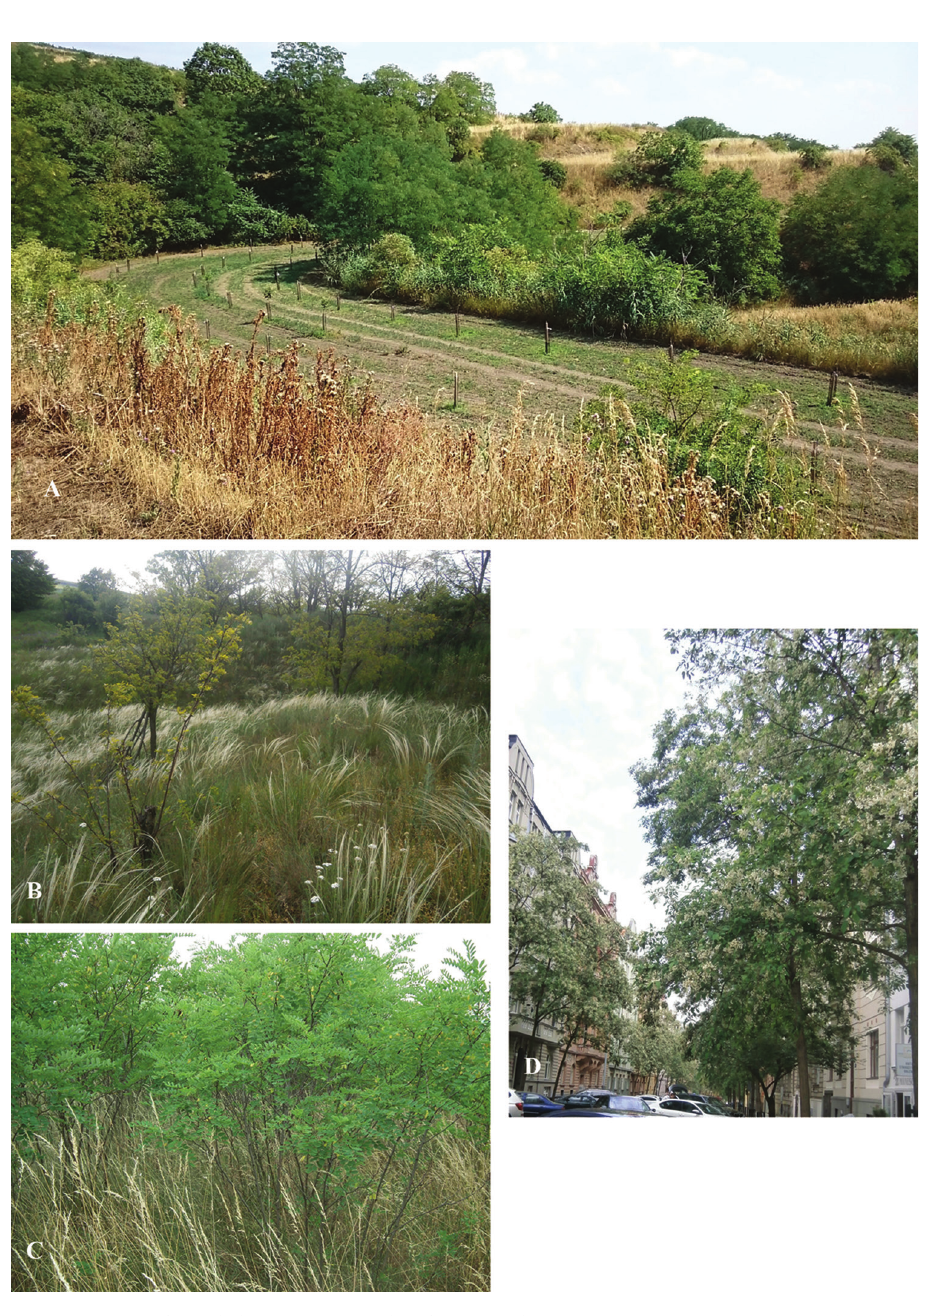
Figure 4. Non-forest habitats ( A–C ) and Robinia in urban environment ( D ). A Agrarian landscape with small-scale and semi-open Robinia stands. The spread of this species is suppressed by regular use of farming practices B Root suckers of Robinia invading a thermophilous grassland, which is the habitat of protected plant species C Intensive short rotation plantation regenerated by coppicing D Avenue of flowering Robinia in Prague (Czech